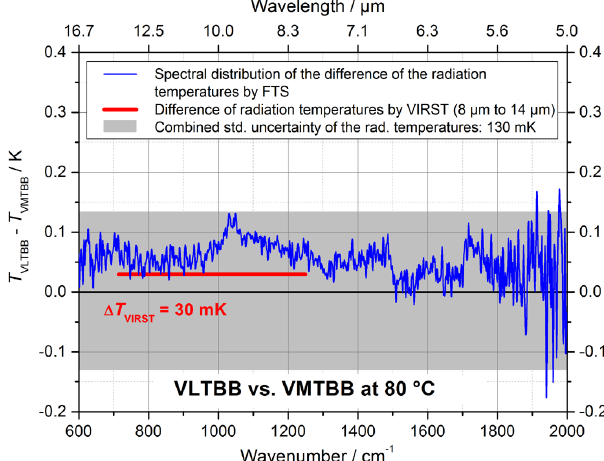
Fig. 11. Difference between the radiation temperatures of the VLTBB and the VMTBB at 80 ◦ C measured with the vacuum FTS (blue line) in the relevant wavelength range of the GLORIA instrument and with VIRST (red line) at the RBCF.